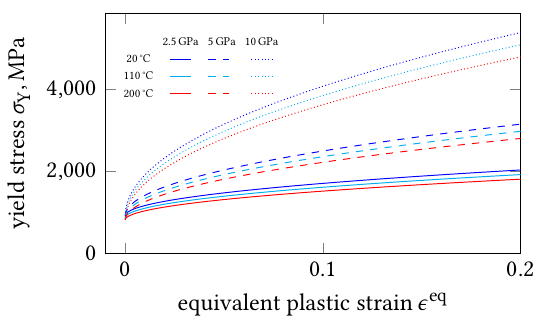
Figure 10. Yield stress as a function of equivalent plastic strain for h different